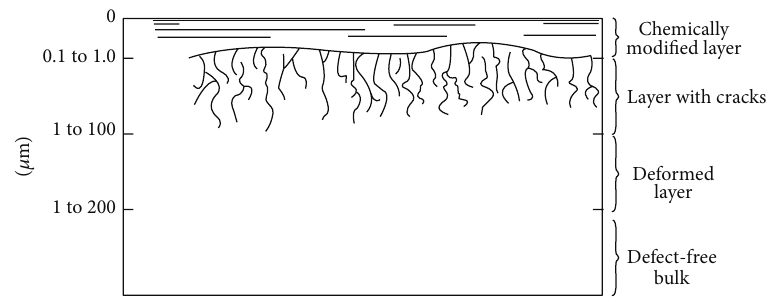
Figure 1: Schematic of the subsurface damage